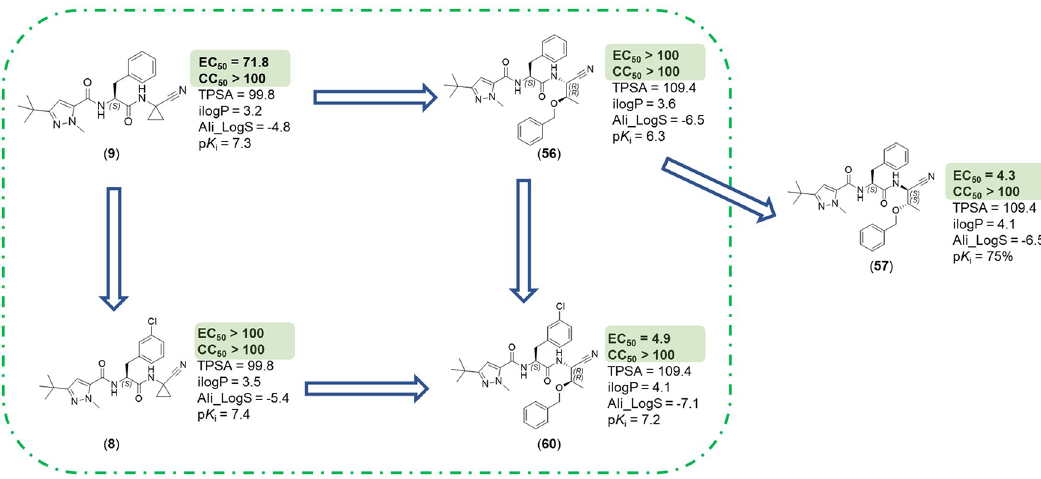
Fig 13. Schematic representation for non-additivity of SARs for trypanocidal activity. EC 50 calculated for amastigote forms of T . cruzi (Tuhaluen strain). CC 50 calculated for the LLCMK2 strain (host cell). Green areas highlight biochemical results. TPSA, ilogP, and Ali_Logs have been calculated with the swissADME online service [29]. p K i values are referring to Cz inhibition.